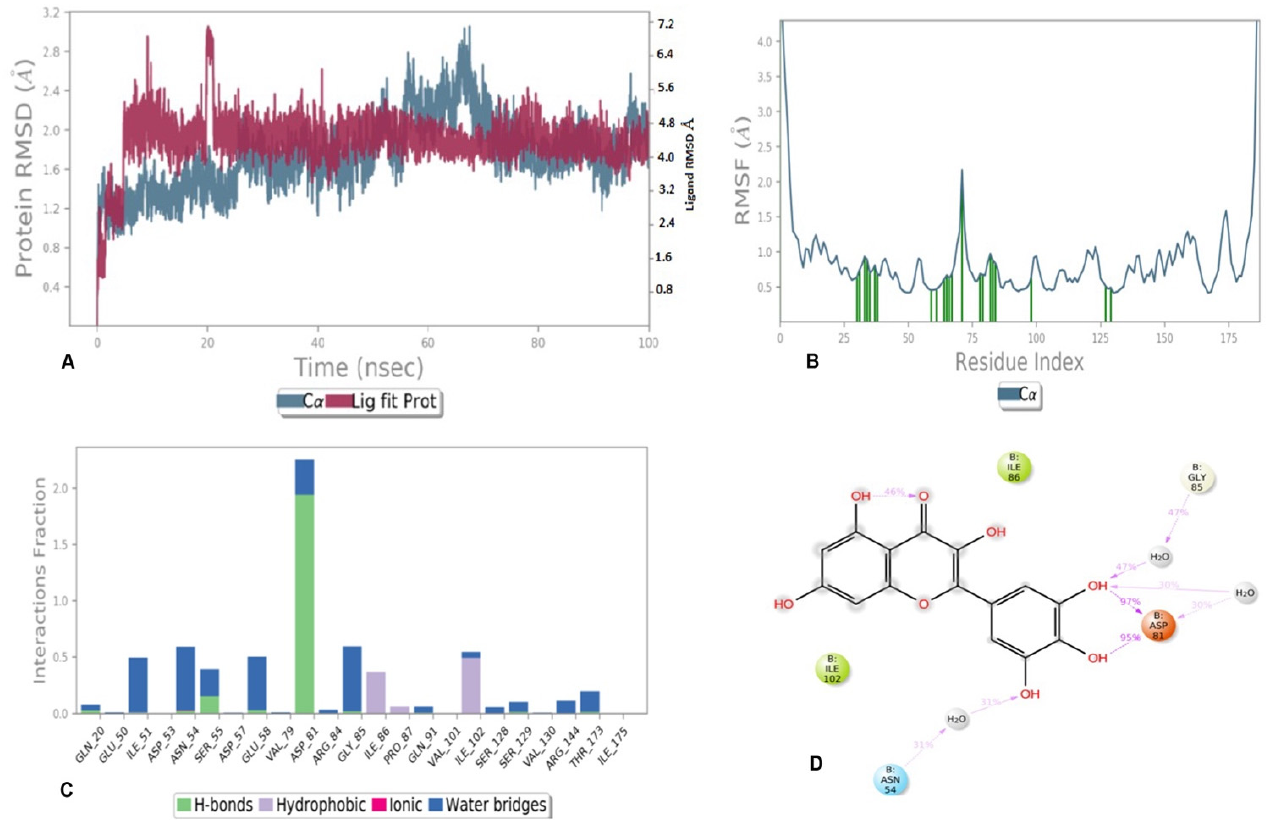
Figure 8. MD simulation results of compound 6 with receptor 5D6P: ( A ) Time-dependent protein- ligand root mean square deviation (RMSD) plots, ( B ) Root mean square fluctuation (RMSF) plots, ( C ) Simulation interactions with bar diagram indicating the fold of interaction, fraction, and contacts, and ( D ) 2D binding interactions.